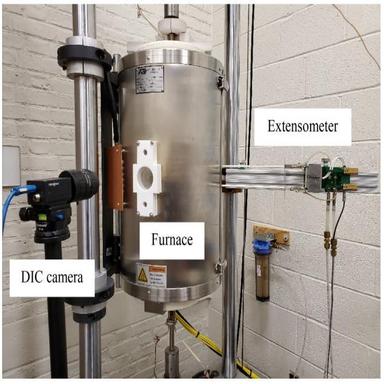
Test apparatus setup in the Multi-Hazard Resilient Structures lab at Johns Hopkins University.